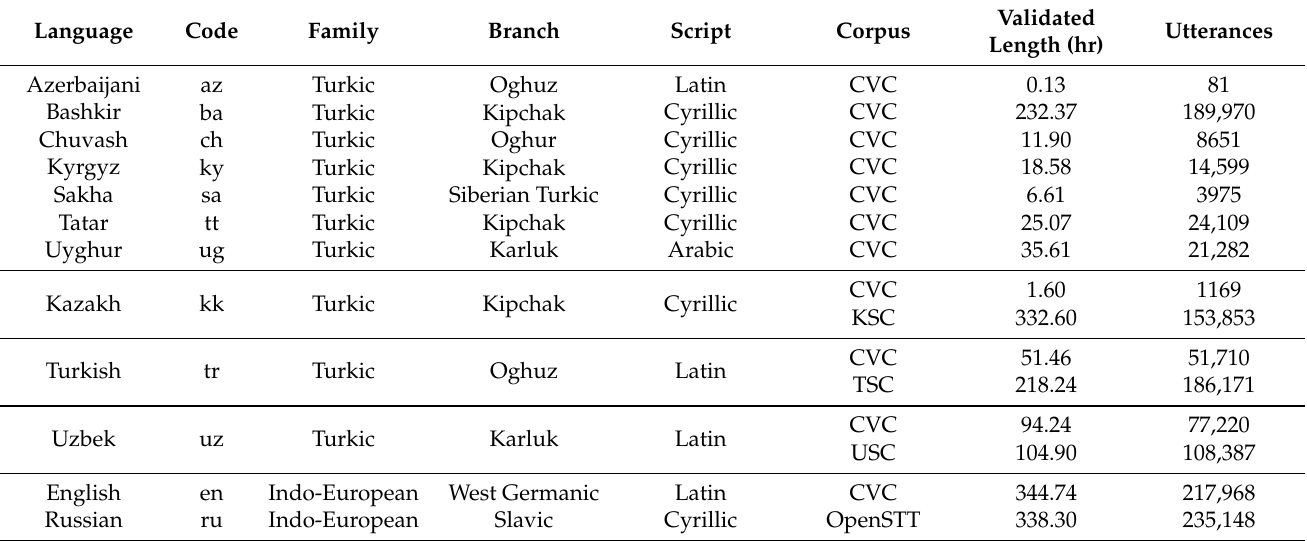
Table 1. The languages and datasets used in the